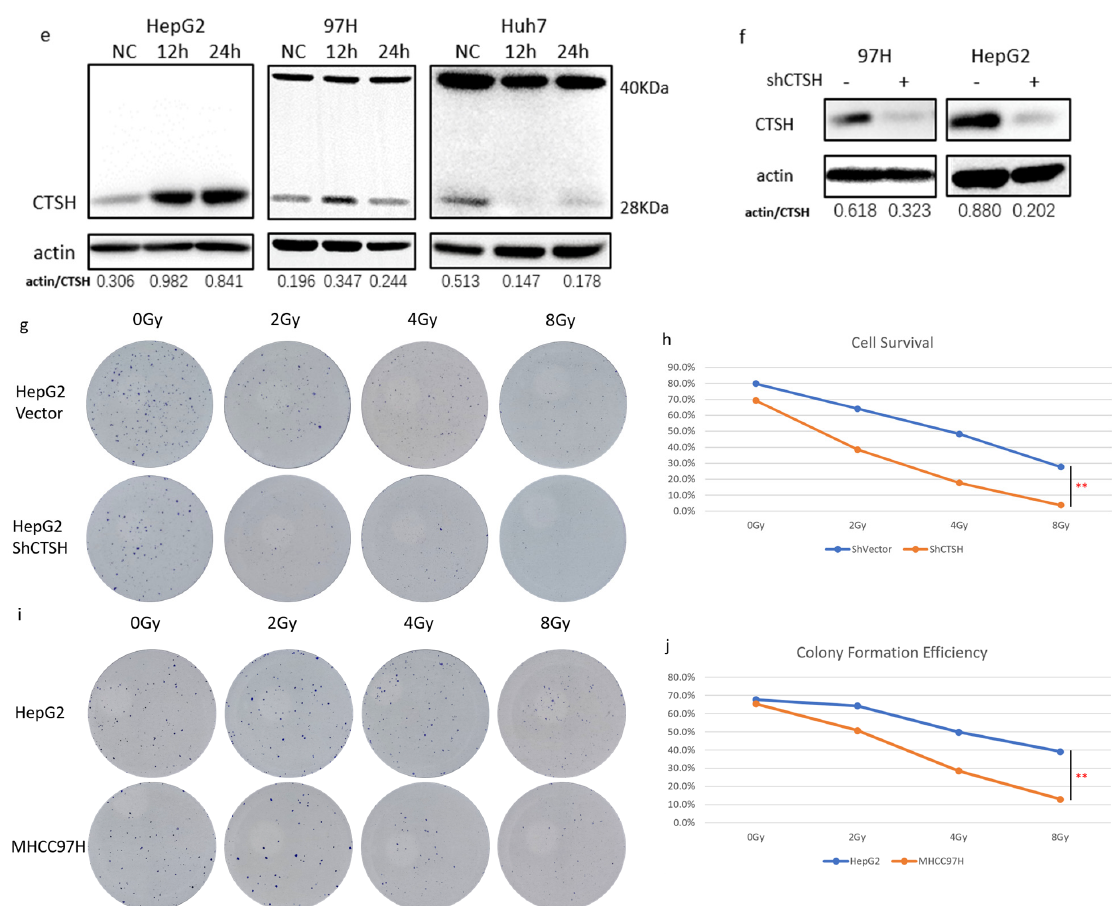
Figure 2. CTSH Participated in Radioresistance Regulation of HCC Cells. ( a ) Heatmap of in vitro PCR array on involved genes from in vivo sequencing; HepG2 and MHCC97H cell lines were used for different doses, and then cells were examined 1 h and 6 h after radiation (IR); ( b , c ) Histograms of gene expression before and after IR in HepG2 and MHCC97-H cell lines; ( d ) Flow cytometry after trypan blue staining verified cell death after IR ( p < 0.05). ZVAD (inhibitor of apoptosis) was applied to cells before IR treatment; ( e ) Western blot result of CTSH protein expression in HepG2, MHCC97-H, and Huh7 cells before and after IR; ( f ) Western blot analysis of CTSH expression for the verification of CTSH knockdown; ( g , h ) Colony formation assay to compare radio-sensitivity between CTSH knockdown and vector cells ( p < 0.05); ( i , j ) Colony formation assay to compare radio-sensitivity between wildtype HepG2 and MHCC97-H cells ( p < 0.05). * p < 0.1; ** p < 0.05; *** p <